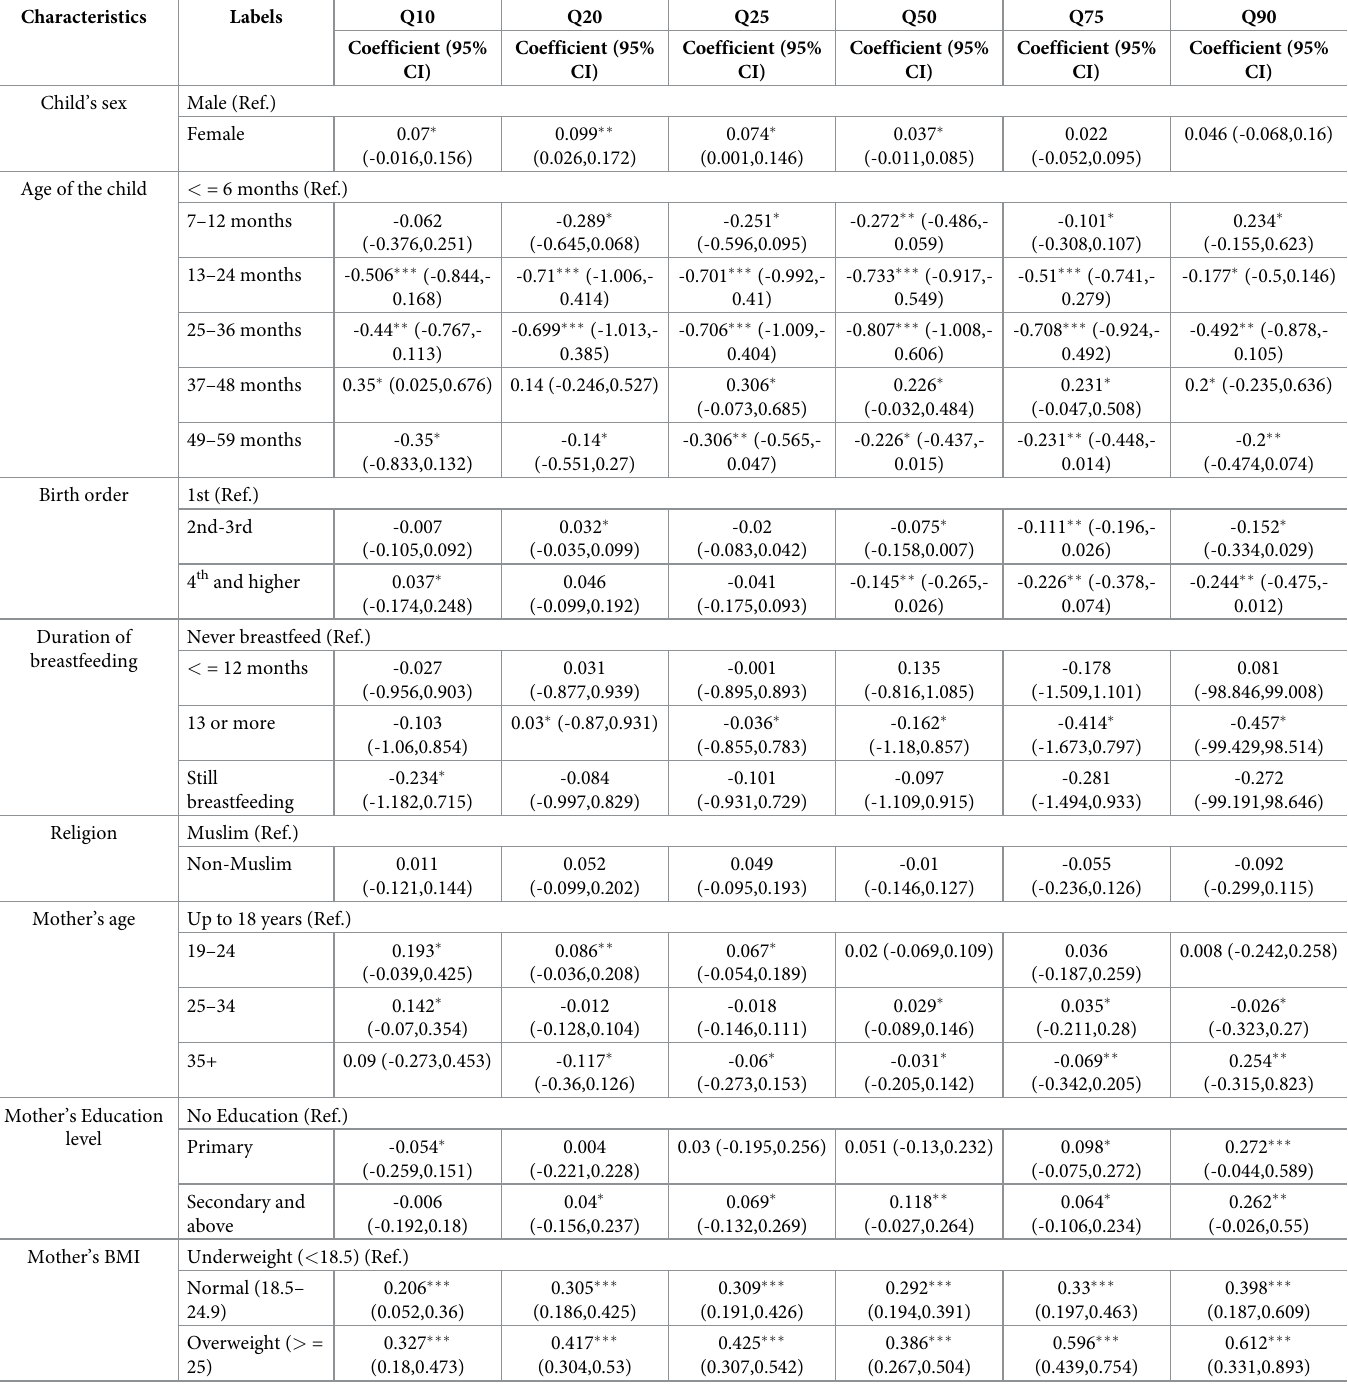
Table 2. Results of quantile regression analysis for WHZ score for under-5 Bangladeshi children.